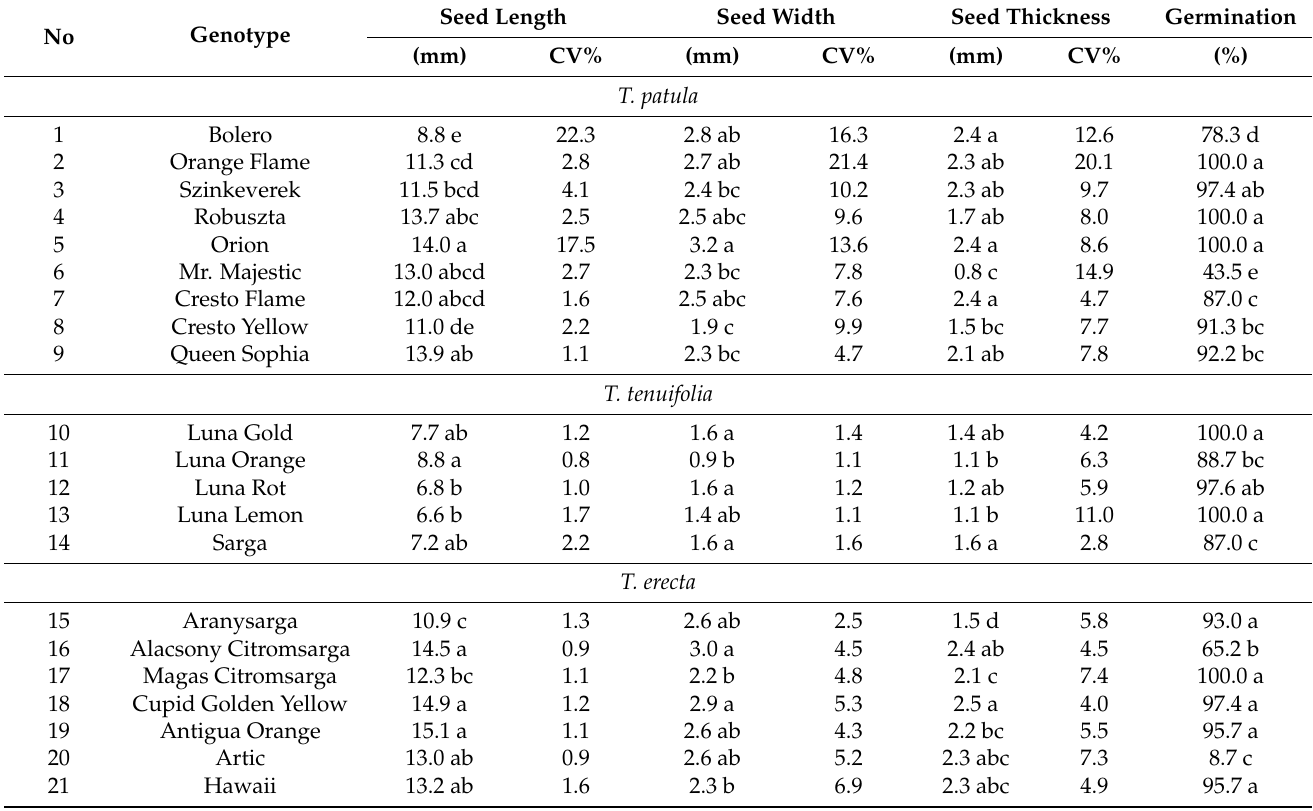
Table 1. Main seed traits and their coefficient of variation for the Tagetes cultivars and the germination capacity of the